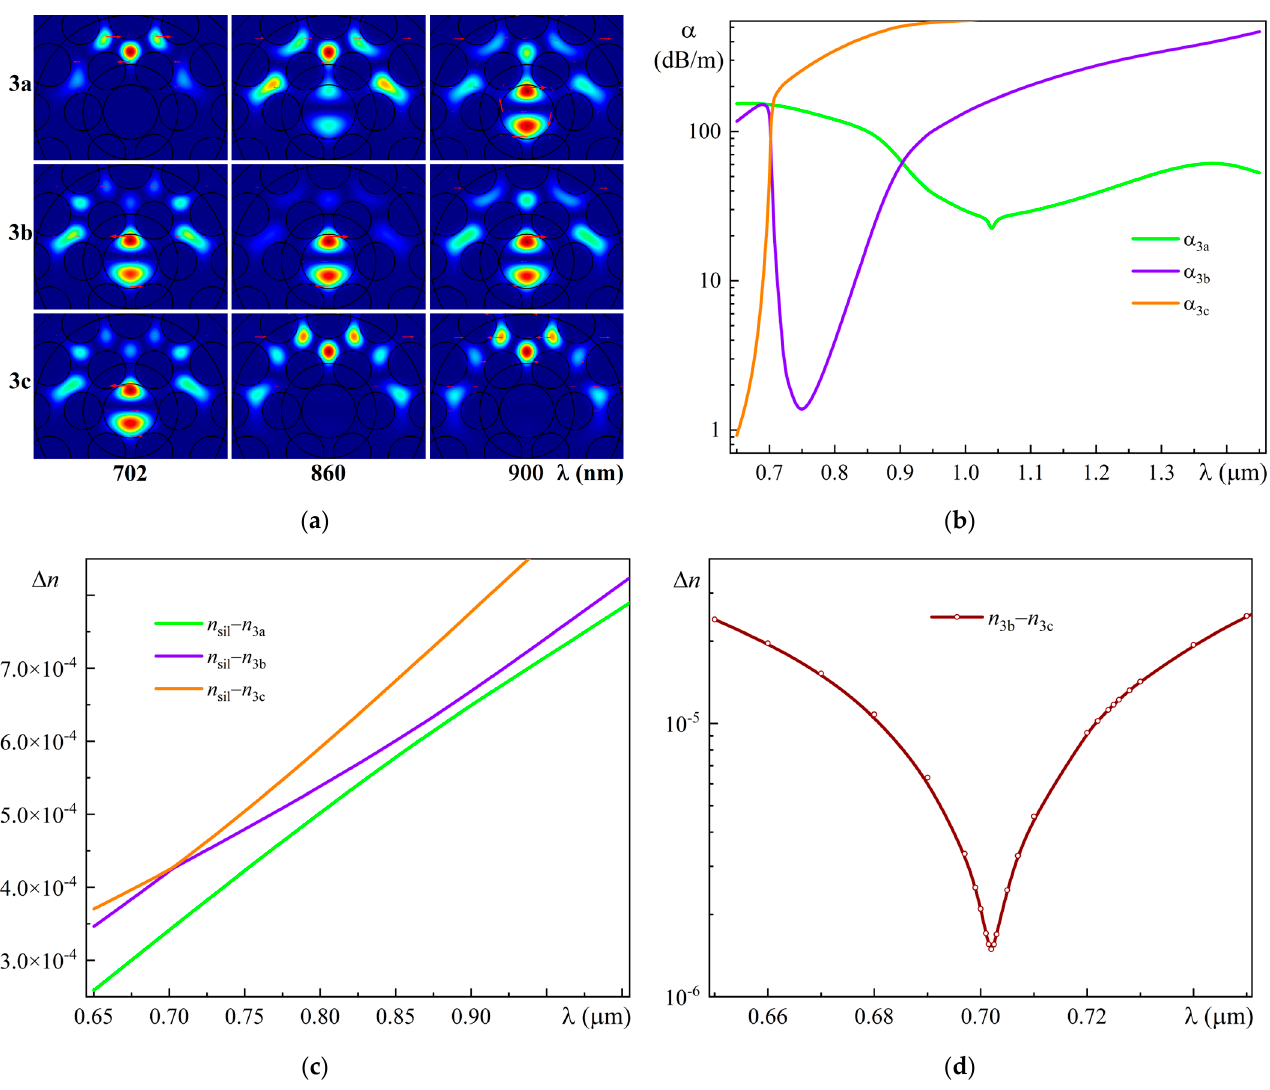
Figure 12. ( a ) Spatial intensity distributions of Modes 3a, 3b, and 3c in the bent MOF-18 for bending radius R y = 0.08 m for wavelengths of 702 nm, 860 nm, and 900 nm; ( b ) Spectral dependences of the leakage losses α 3a , α 3b , and α 3c of Modes 3a, 3b, and 3c in the bent MOF-18 for R y = 0.08 m; Spectral dependences for a bent MOF-18 with R y = 0.08 m: ( c ) of the di ff erence between the refractive indices of pure silica glass and the e ff ective refractive indices of Modes 3a, 3b, and 3c: n sil – n 3a , n sil – n 3b , and n sil – n 3c ; ( d ) of the di ff erence n 3b – n 3c between the e ff ective refractive indices of Modes 3b and 3c.